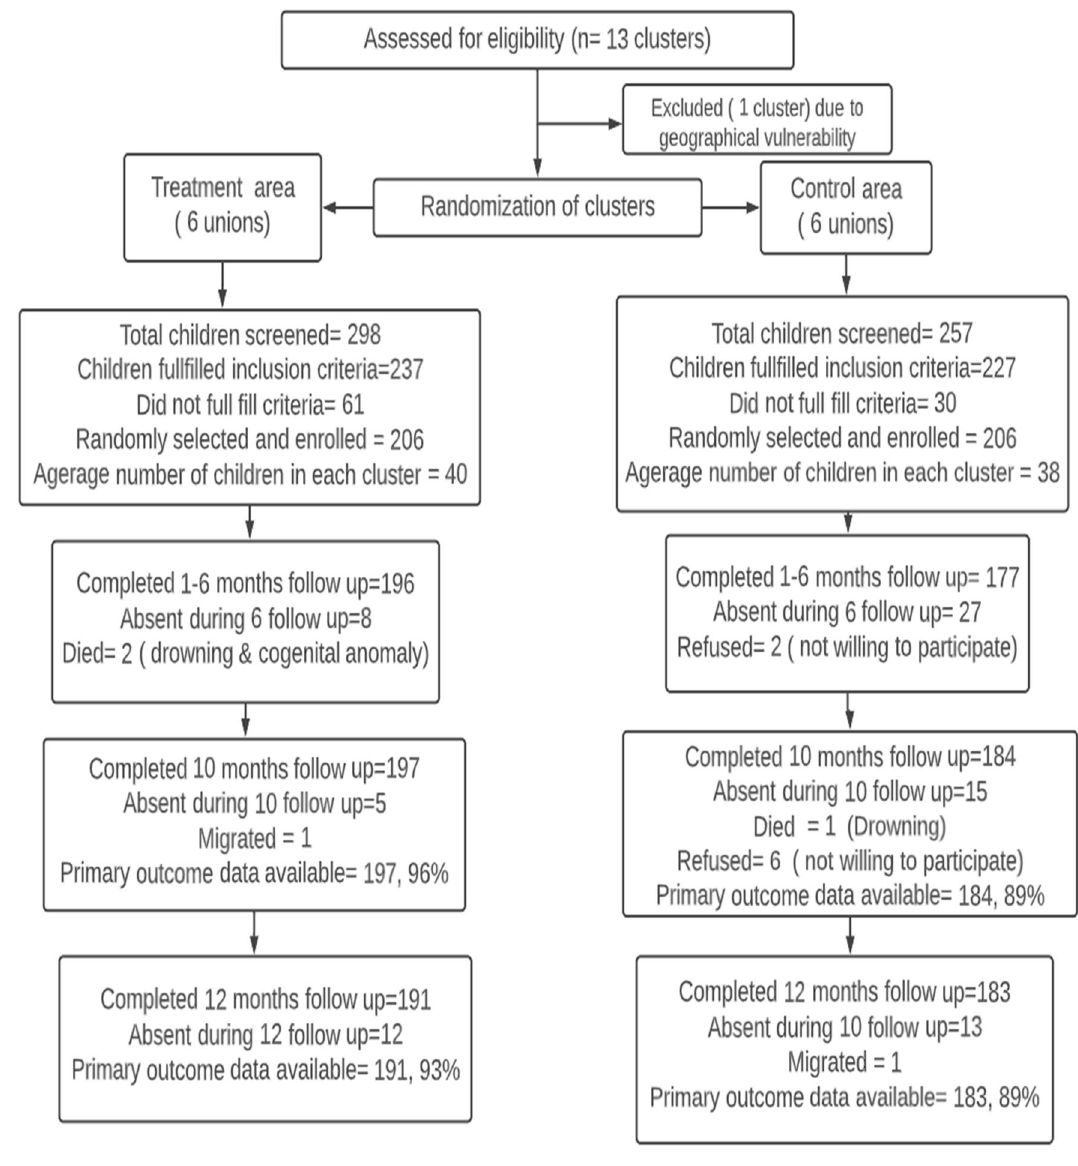
Figure 1. Consort